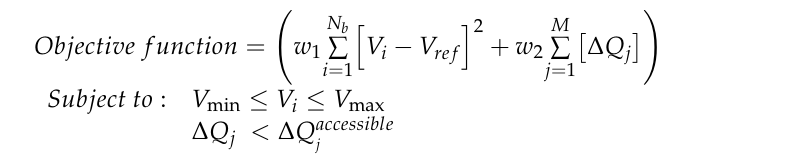
Table 1. Pair-wise comparison and final normalized weights of criteria.